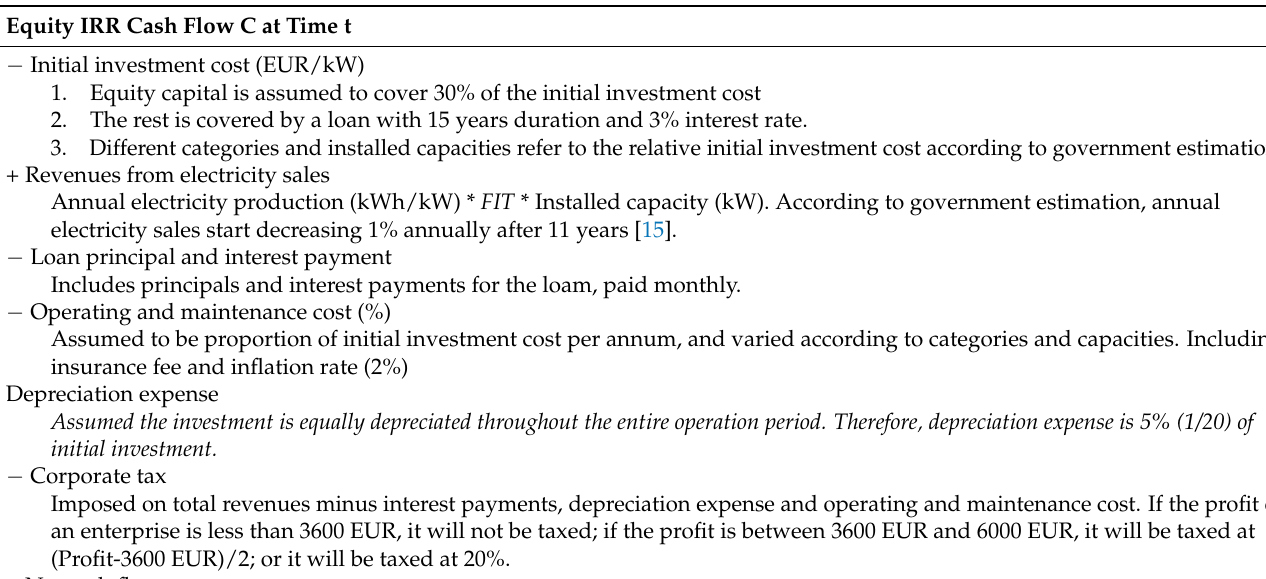
Table 1. Net cash flow